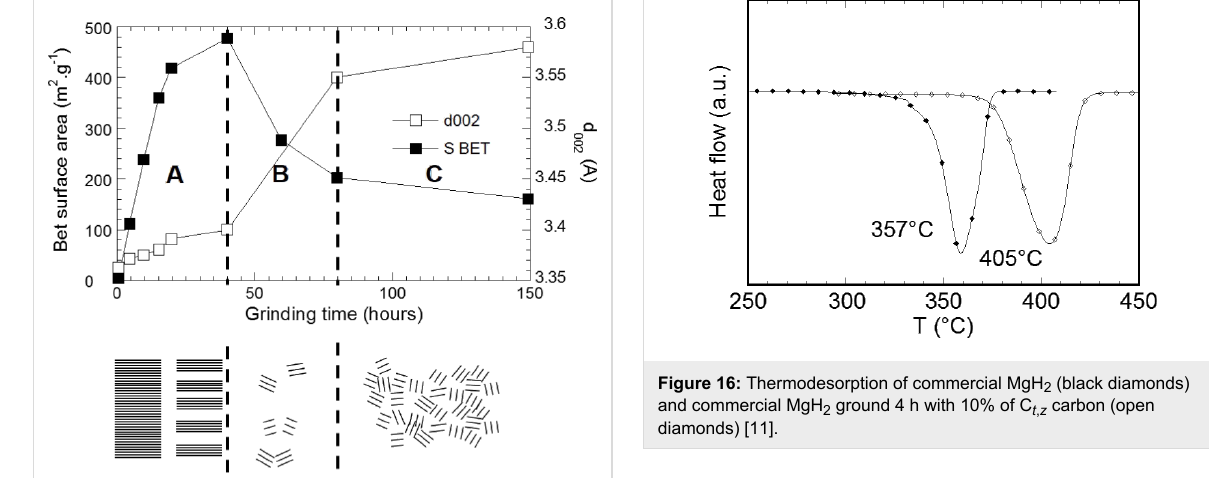
d (002) remains almost constant (step A) and then the BET surface area decrease and d (002) drastically increases (step B).